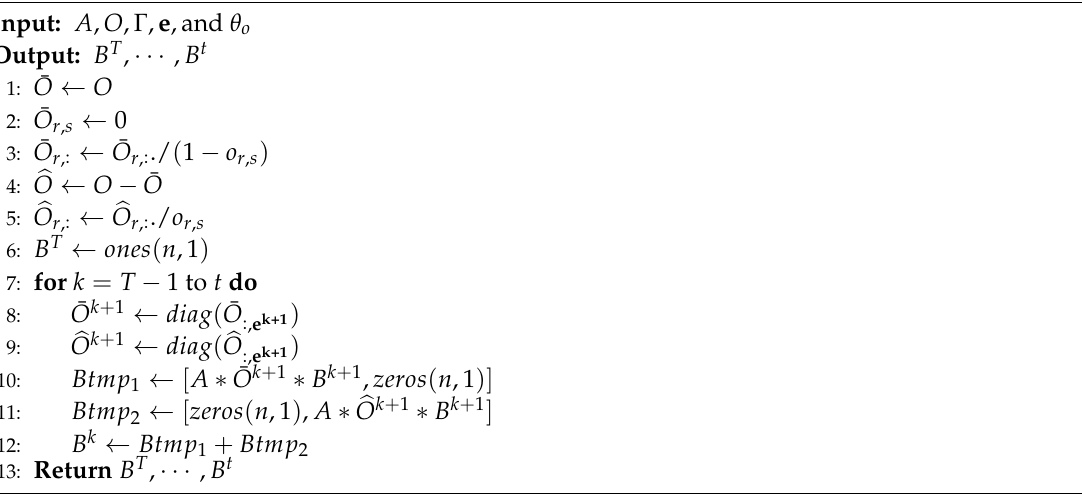
Algorithm 6 This computes the coefficients of the backward probability sensitivity function | x t )( θ ) with θ = o o o r , s in backward matrices B v